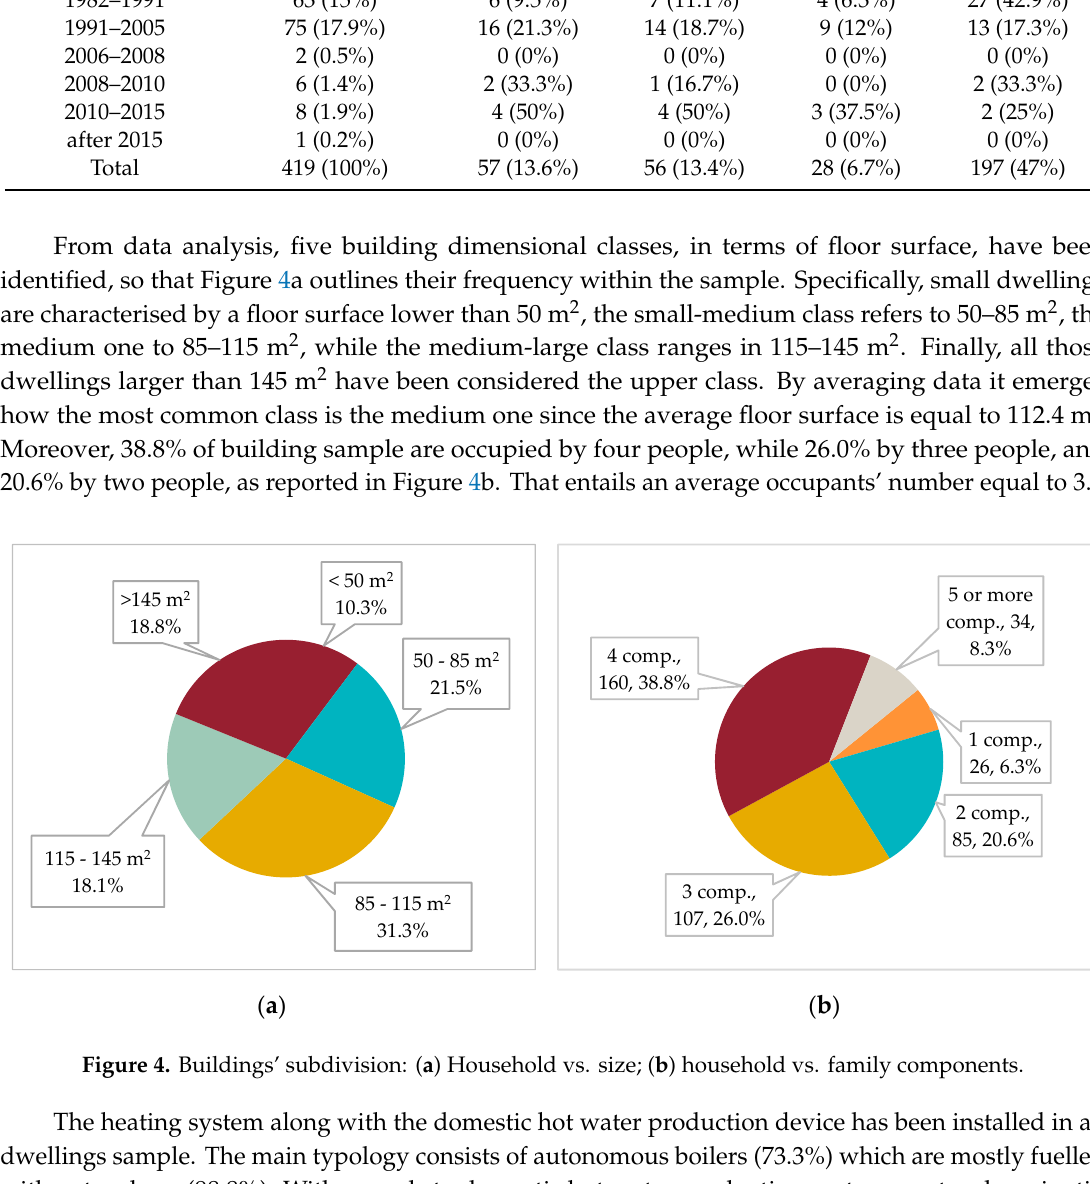
( c ) Figure 5. Equipment: ( a ) Heating systems typology; ( b ) chilled rooms; ( c ) energy label of cooling system. In the end, fixed chillers for inner space cooling have been installed only in 207 dwellings showing that the deployment of those devices is limited to 49.4%. Specifically, only few rooms are served by split units and they are characterised also by high values in energy label, since they have been installed recently, as reported in Figure 5c. Indeed, more than 65% of them have an efficiency class equal to or greater than class A+. Thereafter, only in 77 dwellings (18.4%) there are portable equipment such as fans or dehumidifiers.